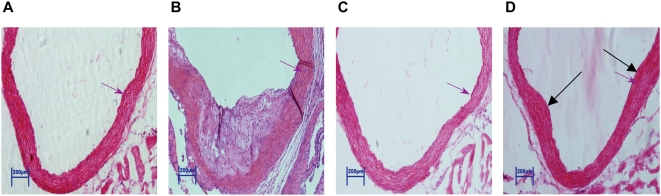
An increase in blood pressure by MCMV infection is independent of atherosclerosis.(A) Aortic root section from a mouse mock-infected and fed a high cholesterol diet showing no visible atherosclerosis. (B) Aortic root section from a mouse infected by MCMV plus fed a high cholesterol diet showing a typical atherosclerotic plaque with numerous foam cells and occasional cholesterol clefts. (C) Aortic root section from a mouse mock-infected and fed a regular diet showing no visible atherosclerosis. (D) Aortic root section from a mouse infected by MCMV and fed a regular diet showing intimal thickenings (arrow pointed) and no visible atherosclerosis. Each group contained 12 mice. All pictures were taken at 20× magnification, and scales are as shown in bar. The vessel wall was measured in the same position (red arrow pointed) of the aortic root of animals fed a high cholesterol diet alone (4 mm), MCMV infected plus fed on a high cholesterol diet (7 mm), fed a regular diet alone (3 mm), and MCMV infected plus fed on a regular diet (6 mm).